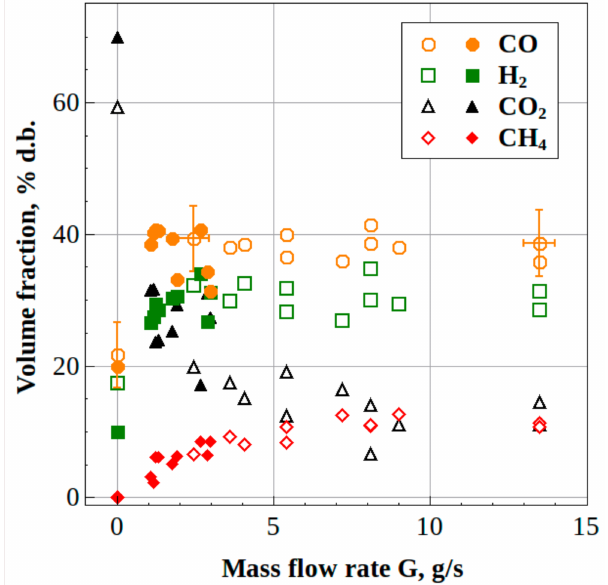
Figure 6. Measured compositions of cooled dry syngas as a function of G ( f = 1 Hz, P ≈ 0.1 MPa) obtained by liquid waste gasification in a 100-dm 3 (filled symbols) and 40-dm 3 (empty symbols) reactors. Bars show measurement